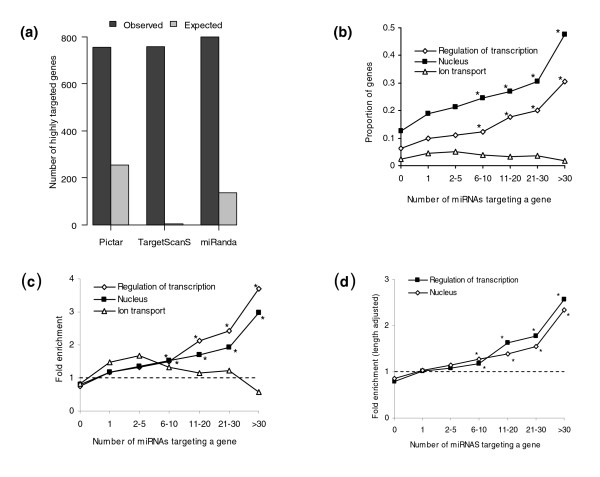
Abundance and functional enrichment of genes targeted by many distinct miRNAs. (a) The observed number of genes targeted by many miRNAs is dramatically greater than the expected number for all three algorithms. The threshold for the number of miRNAs to be considered highly targeted is defined to be one standard deviation more than the average number of miRNAs predicted to target a gene. (b) A large proportion of genes targeted by many miRNAs are transcriptional regulators and nuclear genes, but this enrichment decreases as the number of miRNAs is reduced. Genes involved in ion transporters do not show this trend. In (b-d), asterisks denote P < 0.01. (c) Enrichment, instead of proportion (as before), is shown of transcriptional regulators and nuclear genes for highly targeted genes, with the same enrichment for highly targeted genes. The expected enrichment for a random set of genes targeted by any number of miRNAs is 1.0 (that is, no enrichment), shown by the dotted line. (d) The enrichment of transcriptional regulators and nuclear genes among highly targeted genes remains after controlling for 3' UTR length.